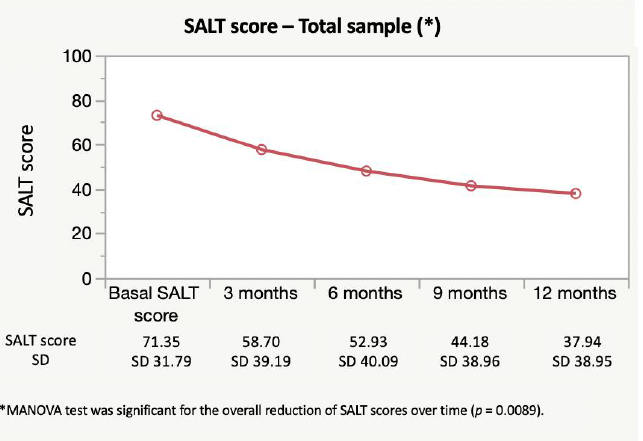
Figure 1. Evolution of SALT scores after the treatment with dexamethasone in the overall sample. A significant decrease of SALT scores was observed. However, when a stratified analysis was performed for the age of onset, it was found that the decrease of SALT scores was not uniform between groups. Even though there were no significant differences in basal characteristics between the two groups (Table 2), “early onset” patients did not show a decrease in SALT scores over time ( p = 0.44); whereas, “late onset” patients did ( p < 0.01). The evolution of SALT scores in these groups can be seen in Figure 2. Table 2. Basal characteristics in “early” and “late” onset groups. No differences were found between groups in any of the variables analyzed. Variables